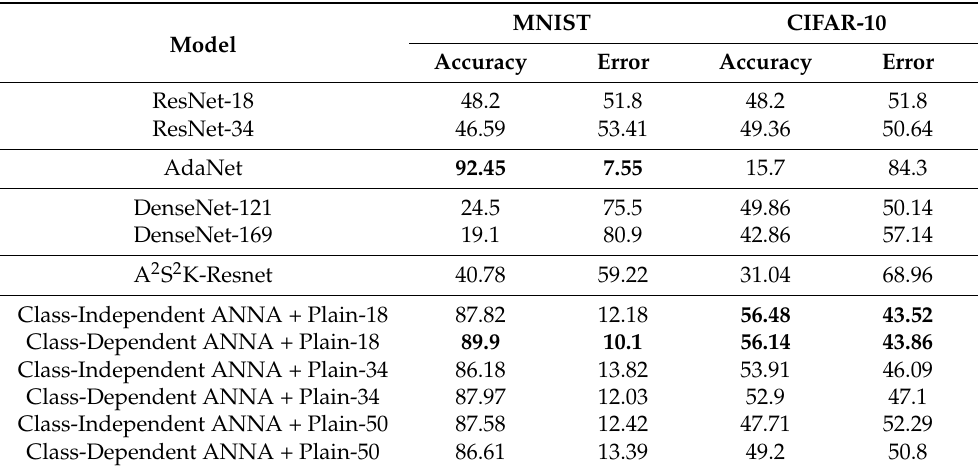
dataset and CIFAR-10